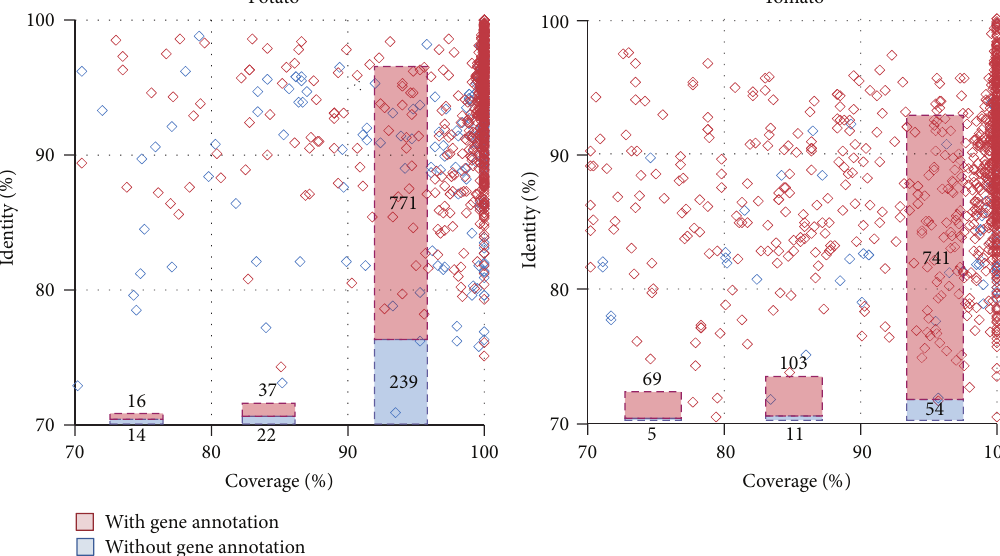
Figure2:DArTmarkersequencesalignpredominantlywithgenecodingregionsofthepotatoandtomatogenome.Thealignmentsassociated (or not) to a gene locus along the potato and tomato genomes are highlighted in red (or blue). For each group, the number of alignments is also